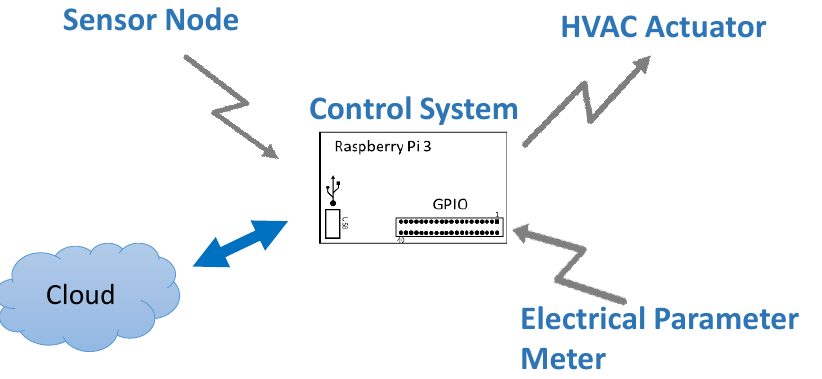
Figure 1. Control system scheme diagram.